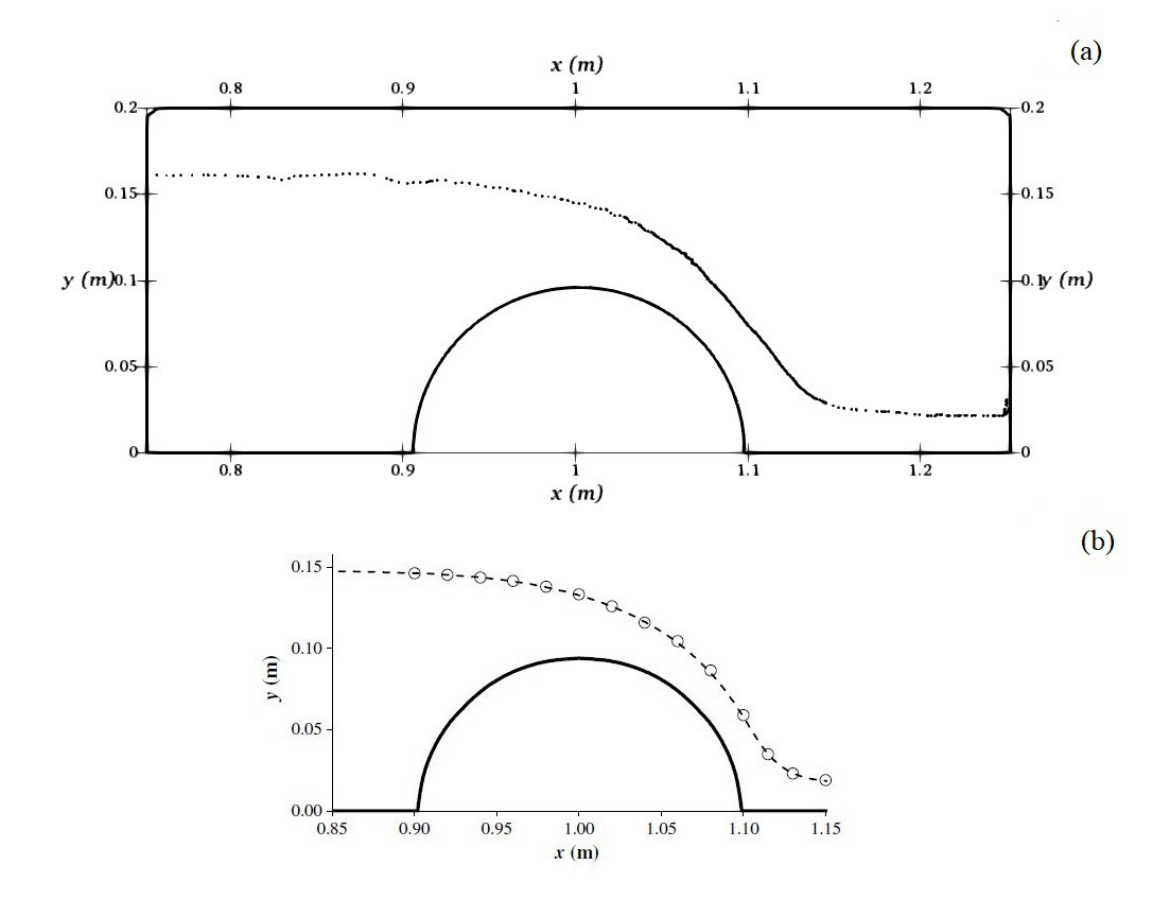
Figure 8. Comparison of free surface profile in the channel over the semicylindrical dam: ( a ) obtained with caffa3d and ( b ) presented in [33] through exprimental (o) and numerical